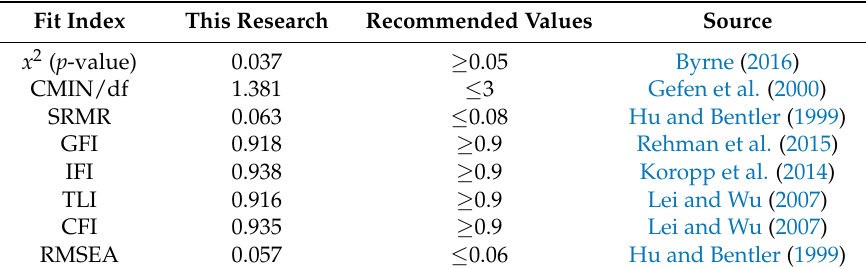
Table 7. Fit indices for the performance